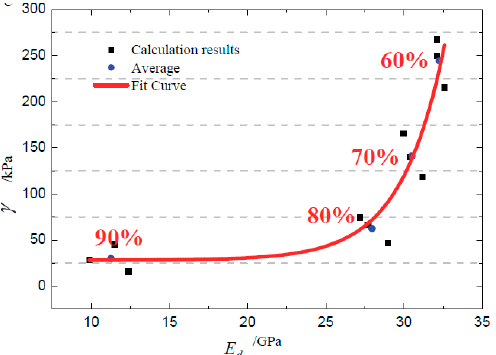
Figure 12. Relationship between the dynamic elastic modulus and the damage strain energy release rate.